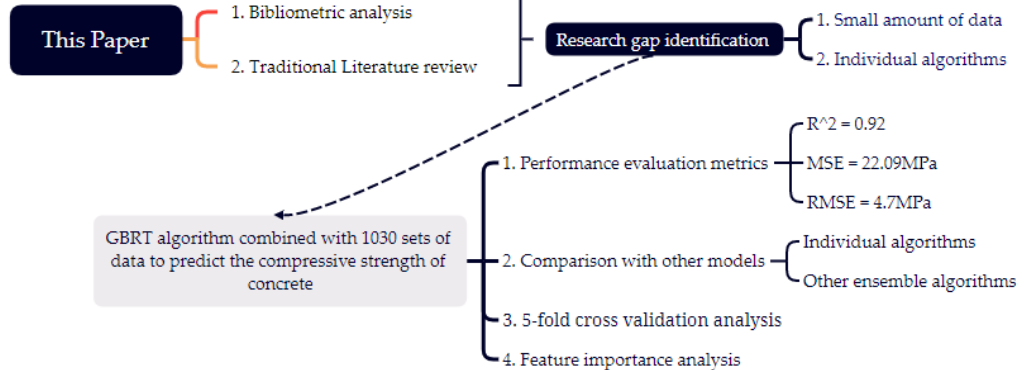
Figure 1. Structure of this paper.